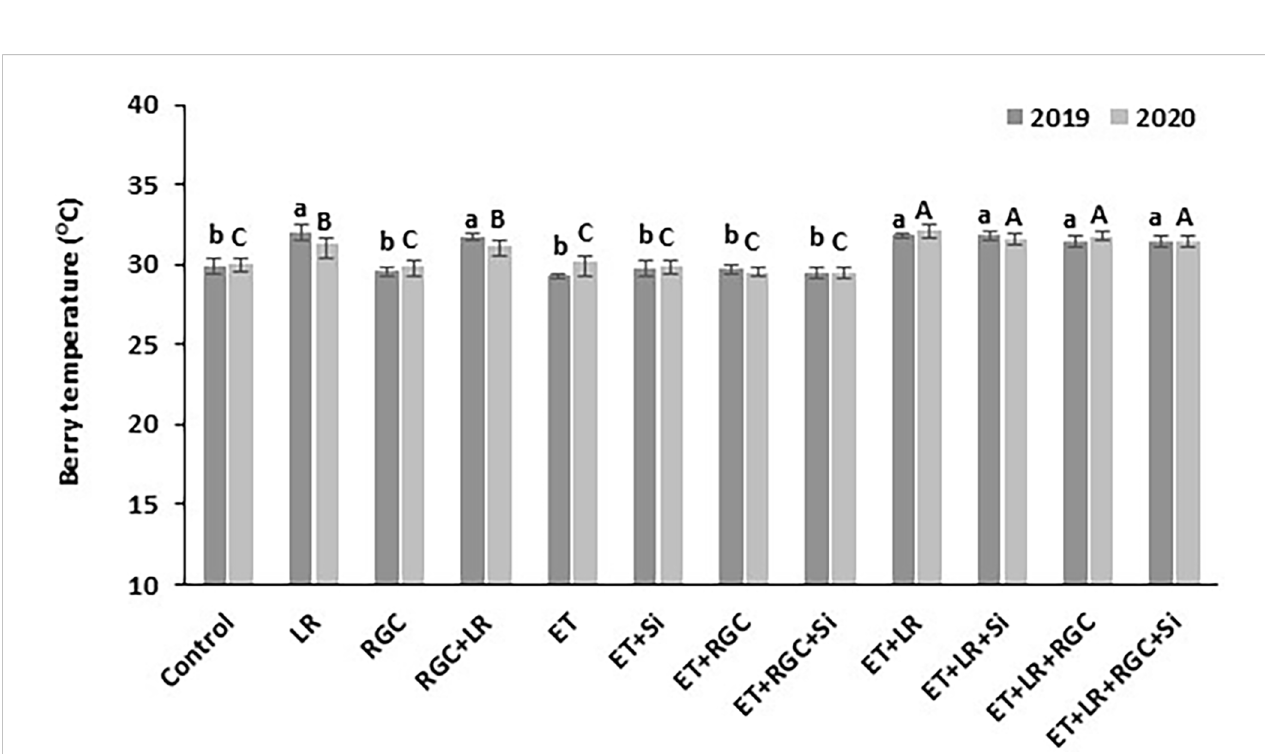
FIGURE 7 Berry temperature measured at mid-day as affected by the different treatments. Treatments were: ethephon (ET), silicon 7% (Si), light-re fl ective ground cover (RGC), and their combinations. Treatments have been conducted with or without cluster-zone leaf removal (LR). The effect of Si alone is not reported in the fi gure, Values are the mean of four readings, and the error bars represent the standard deviation. Different letters on bars indicate signi fi cant differences within the same year at p < 0.05 according to the Tukey HSD test within the same season. Different lower-case letters indicate a signi fi cant difference in 2019 while capital letters are used for 2020. Data were recorded once at the mid-day of June 17 th , 2019, and June 19 th ,